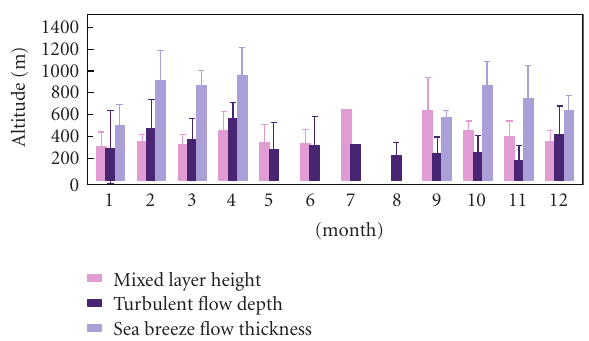
Figure 4: Monthly variations in mixed layer height (MLH), turbulent flow depth (TFD), and sea breeze flow thickness (SBFT) shown as histograms. Error Bars associated with these parameters indicate the standard deviations for each month, respectively.